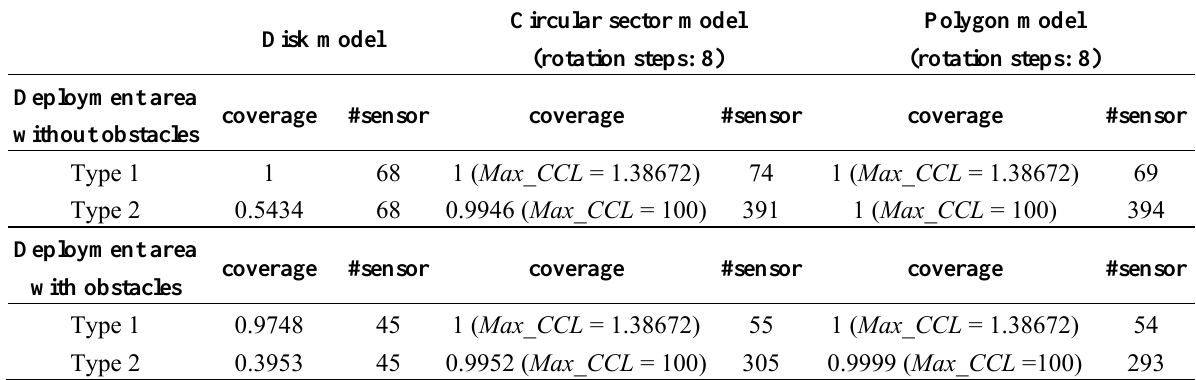
Table 6. The maximum sensing coverage rates and the usage of sensor nodes for each type in Case